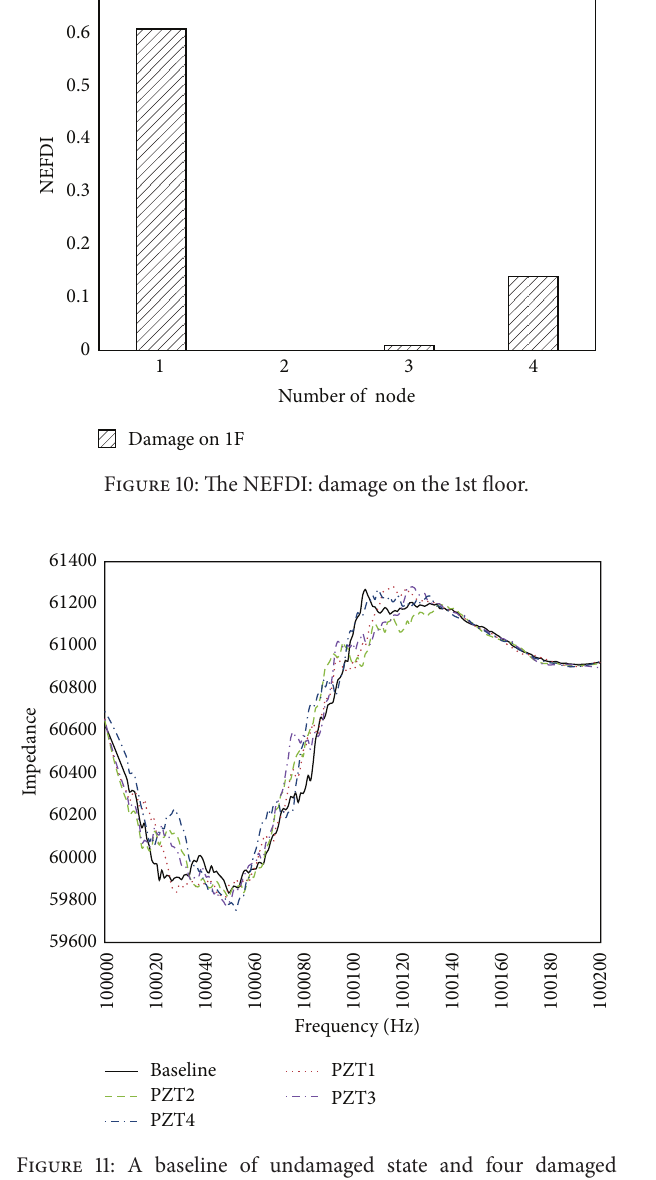
Figure 11: A baseline of undamaged state and four damaged impedance curves.